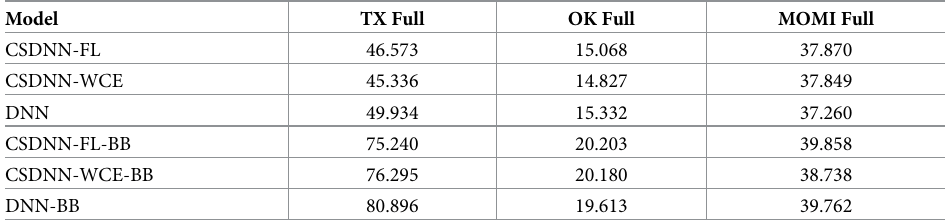
Table 15. Average computational running time (in seconds) of each proposed